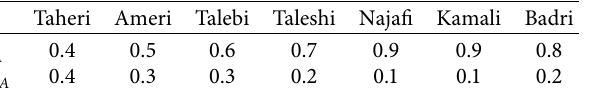
Table 3: The level of staff capability.